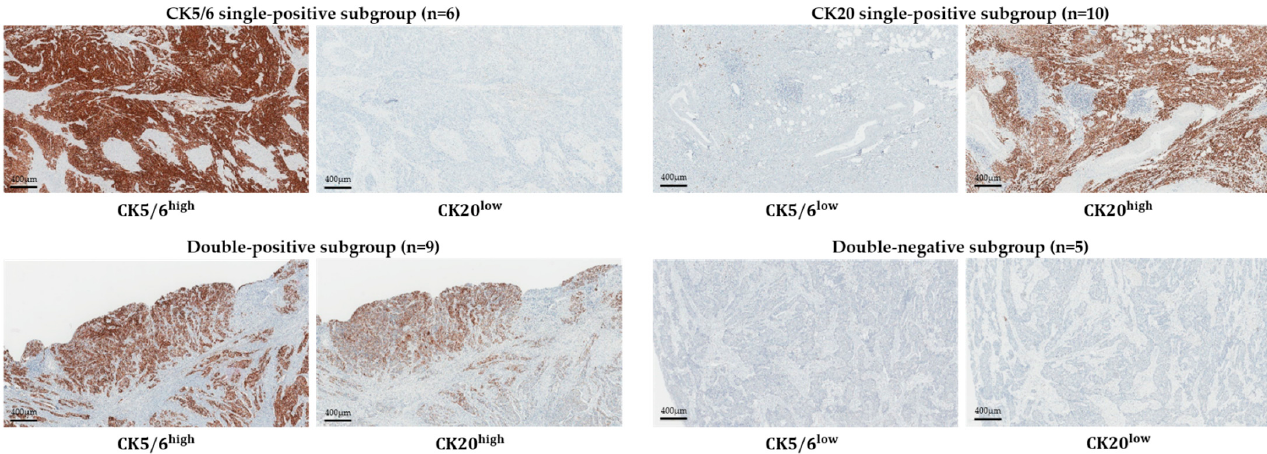
Figure 1. Subgrouping of muscle-invasive urinary bladder cancer (MIBC) by CK5/6 and CK20 immunohistochemistry (IHC).